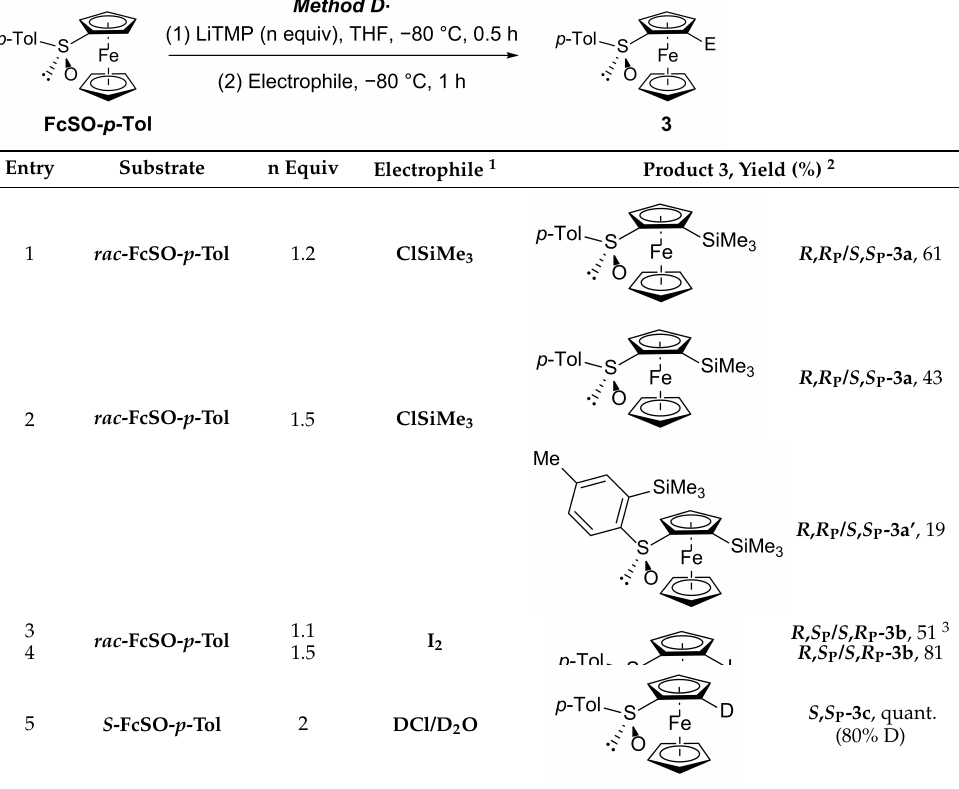
Table 3. Deprotometalation of racemic S -(4-tolyl)ferrocenesulfoxide ( rac -FcSO- p -Tol ) or ( S )- S